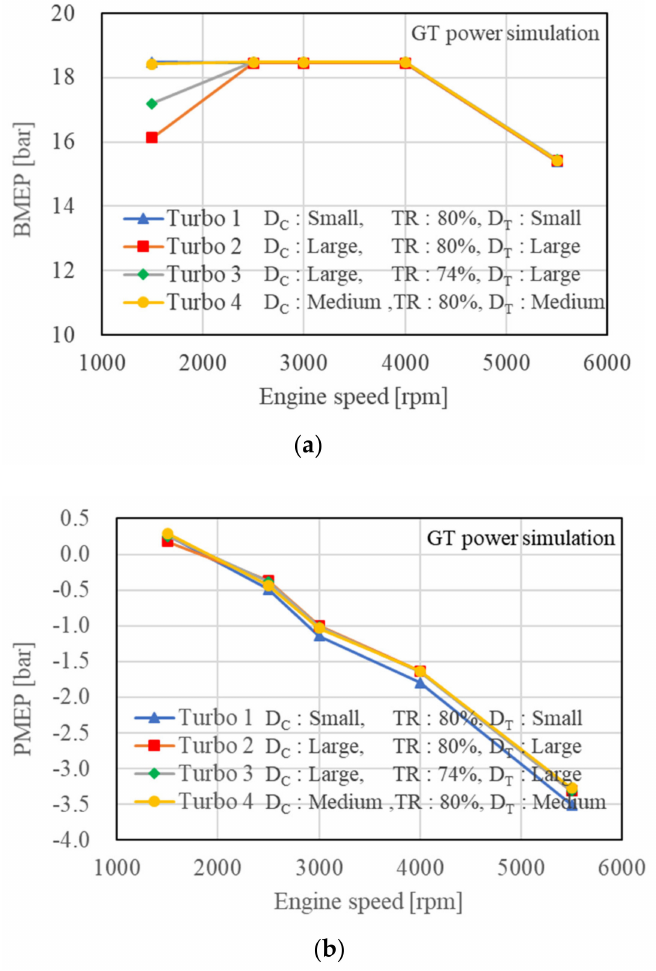
Figure 5. GT power simulation result for full load engine performance: ( a ) Engine torque; ( b )